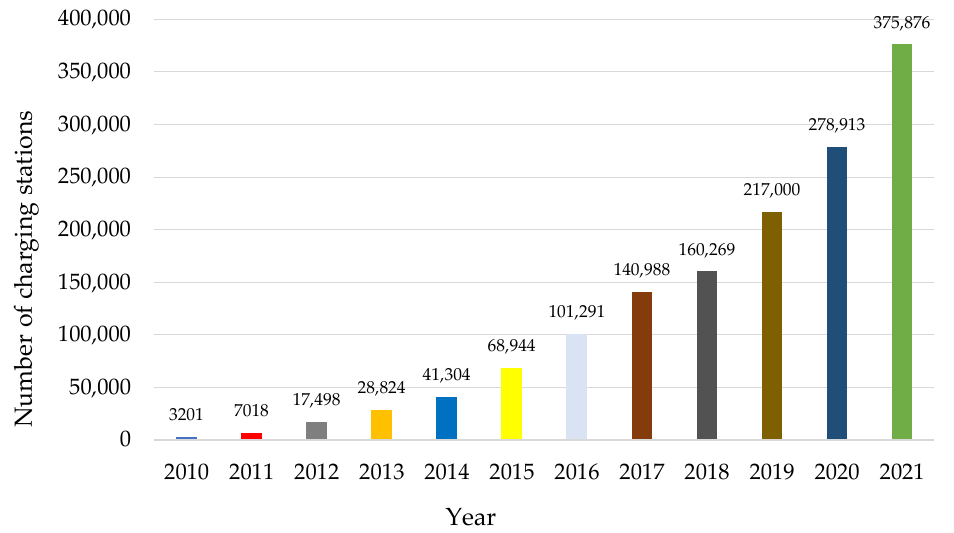
Figure 7. Number of electric vehicle charging stations in Europe 2010 – 2021.